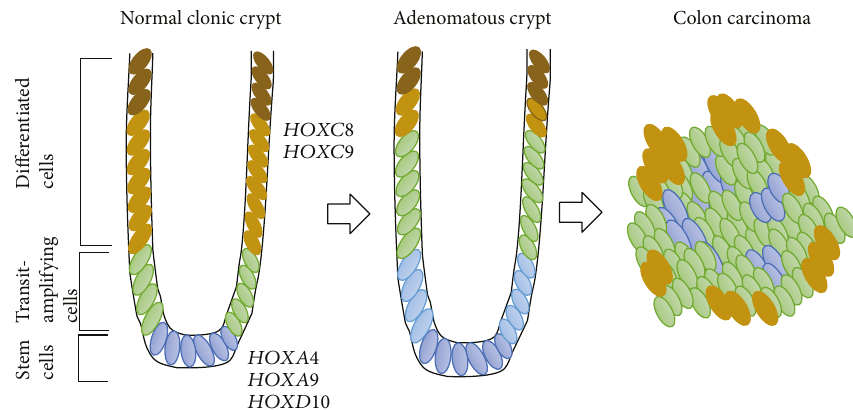
Figure 3: HOX gene expression during colonocyte di ff erentiation. Normal colonic crypts consist of mainly three types of cells based on their location in the crypt. Colon stem cells (SCs) reside at the base of the colonic crypt (shown in blue color). HOXA4 , HOXA9 , and HOXD10 are expressed in colonic SCs and regulate colonic crypt SC di ff erentiation [49, 50]. SCs generate transit-amplifying cells (shown in green color) that are actively proliferating and di ff erentiating (shown in gold-bronze yellow color) as they move up the axis in the colonic crypt. Finally, fully di ff erentiated or terminally di ff erentiating cells are found at the top of the crypt (shown in brown color). Studies have shown that HOXA family genes are expressed mostly in proliferating colonic cells, and HOXC family genes are expressed in di ff erentiating cells [68]. HOXB and HOXD family genes are expressed throughout the colonic crypts [68]. In colon tumors, the dysregulation of HOXA4 and HOXA9 in colon SCs caused aberrant self-renewal and proliferation, contributing to colon carcinoma [50]. HOXC8 and HOXC9 are expressed in the di ff erentiating cells in the colonic crypt